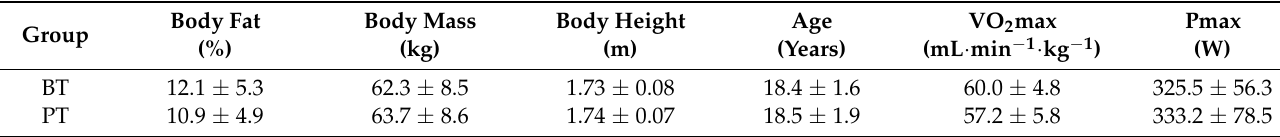
Table 1. Characteristics of experiment